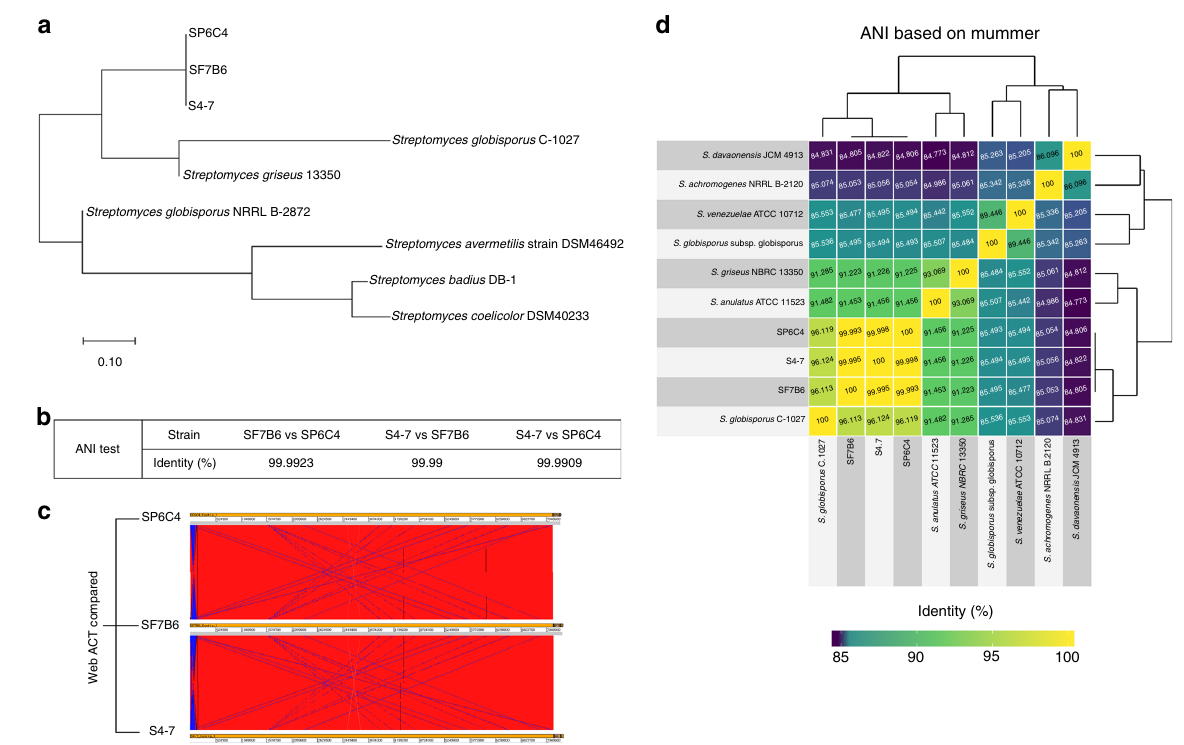
Fig. 2 Identi fi cation of strains SP6C4, SF7B6, and S4-7 at the genome level. a Phylogenetic tree of strains SP6C4, SF7B6, and S4-7 based on 16S rRNA and housekeeping genes ( gyrB and recA ). Sequences were compared by multiple alignment analyses using the Maximum Likelihood method of MEGA 7. b Average nucleotide identity (ANI) of the strains. c Web ACT (http://www.webact.org/WebACT), blast parameters of nucleotide mismatch penalty − 1; gap opening penalty 1; gap extension penalty 2. d ANI genome alignment threshold was raised to 94%. b – d Source data are provided as a Source Data fi